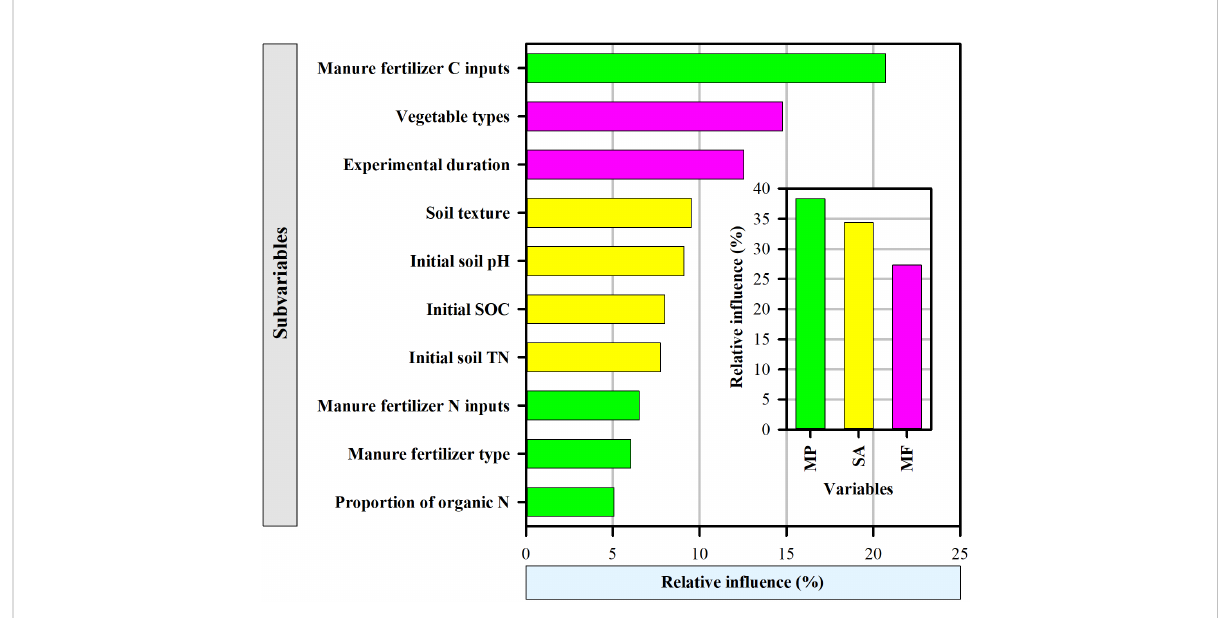
FIGURE 6 The relative in fl uence (%) of organic fertilizer properties ( i.e. , organic fertilizer C inputs, proportion of organic N, organic fertilizer type, organic fertilizer N inputs), soil properties ( i.e. , initial soil total nitrogen, initial soil organic carbon, initial soil pH, soil texture) and managerial factors ( i.e. , experimental duration, vegetable types) on vegetable yield based on aggregated boosted tree (ABT) model analysis. Figure abbreviations denote manure properties (MP), soil properties (SA), managerial factors